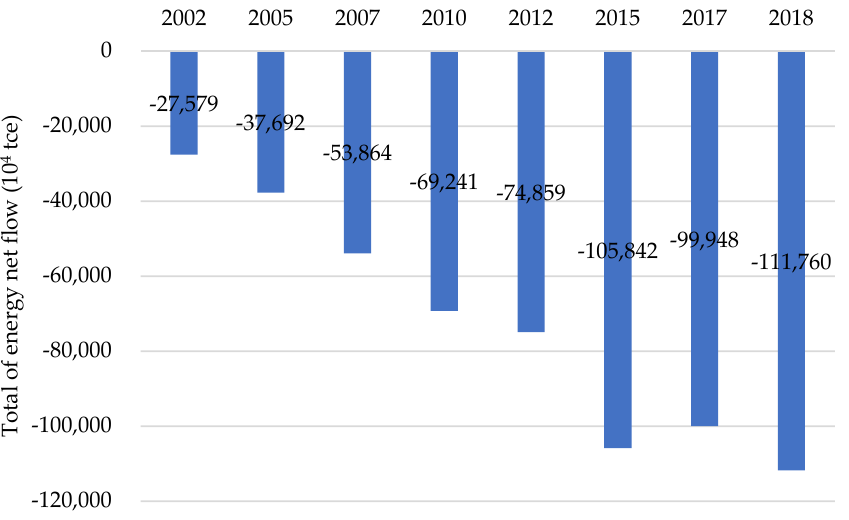
Figure 3. The total of energy net flow of the Chinese construction sector, 2002–2018.